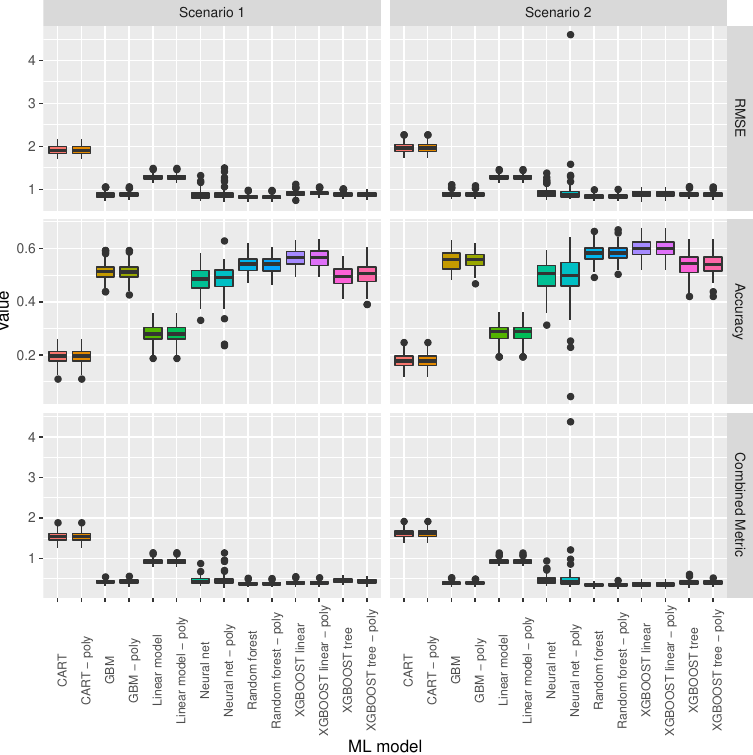
Figure 6. Performance metrics for different ML models trained and tested under the scenarios specified in Table 1.